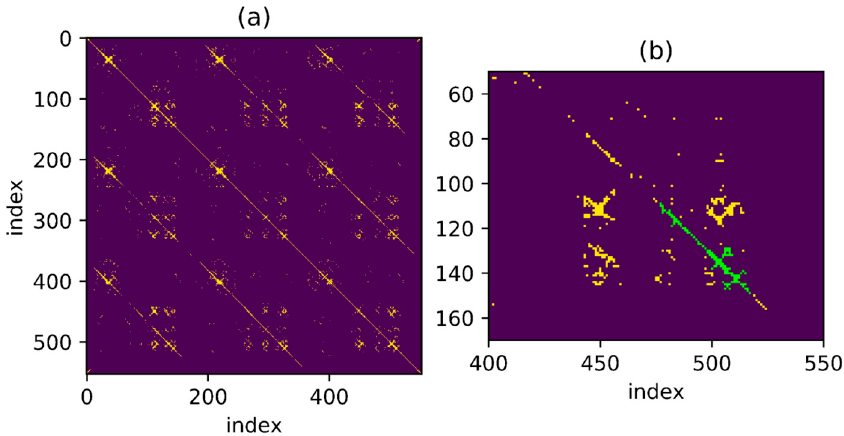
Figure 7. Pairs of distance in feature space smaller than threshold. ( a ) Image of the whole process; ( b ) A typically connected region.